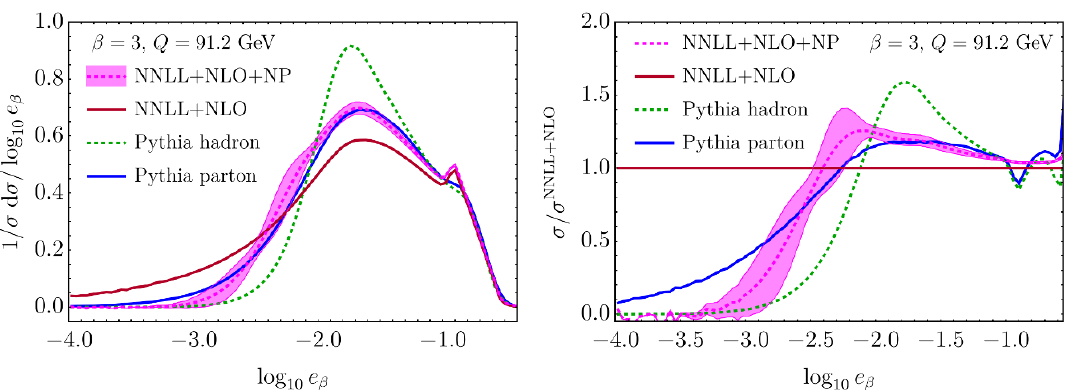
Figure 9 . NNLL+NLO without and with nonperturbative e(cid:11)ect, compared to Pythia at parton and hadron level for Q = 91 : 2 GeV and (cid:12) = 3. The band provides an estimate of the nonperturbative uncertainty, as described in the text, which is sizable due to the smaller value of Q .